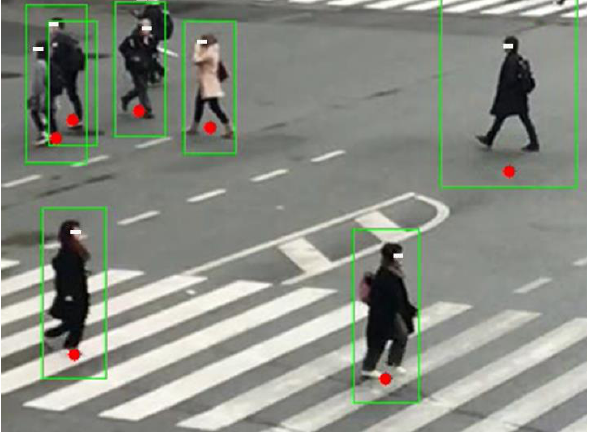
Figure 5. Green blocks are used by the system to identify each individual person (detection frame) while red dots are used to track footsteps as data